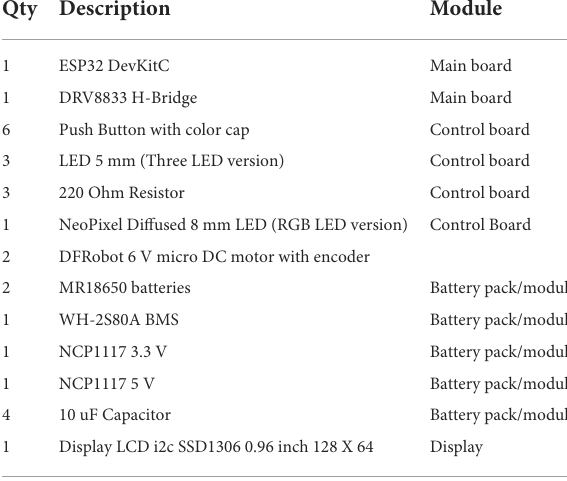
TABLE 1 Hardware components of the robot